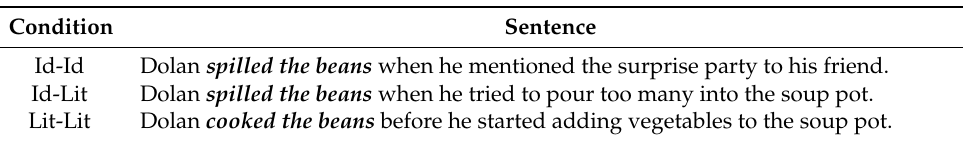
Table 2. Example sentences from Idiomatic–Idiomatic (Id-Id), Idiomatic–Literal (Id-Lit), and Literal– Literal (Lit-Lit) conditions (Experiment